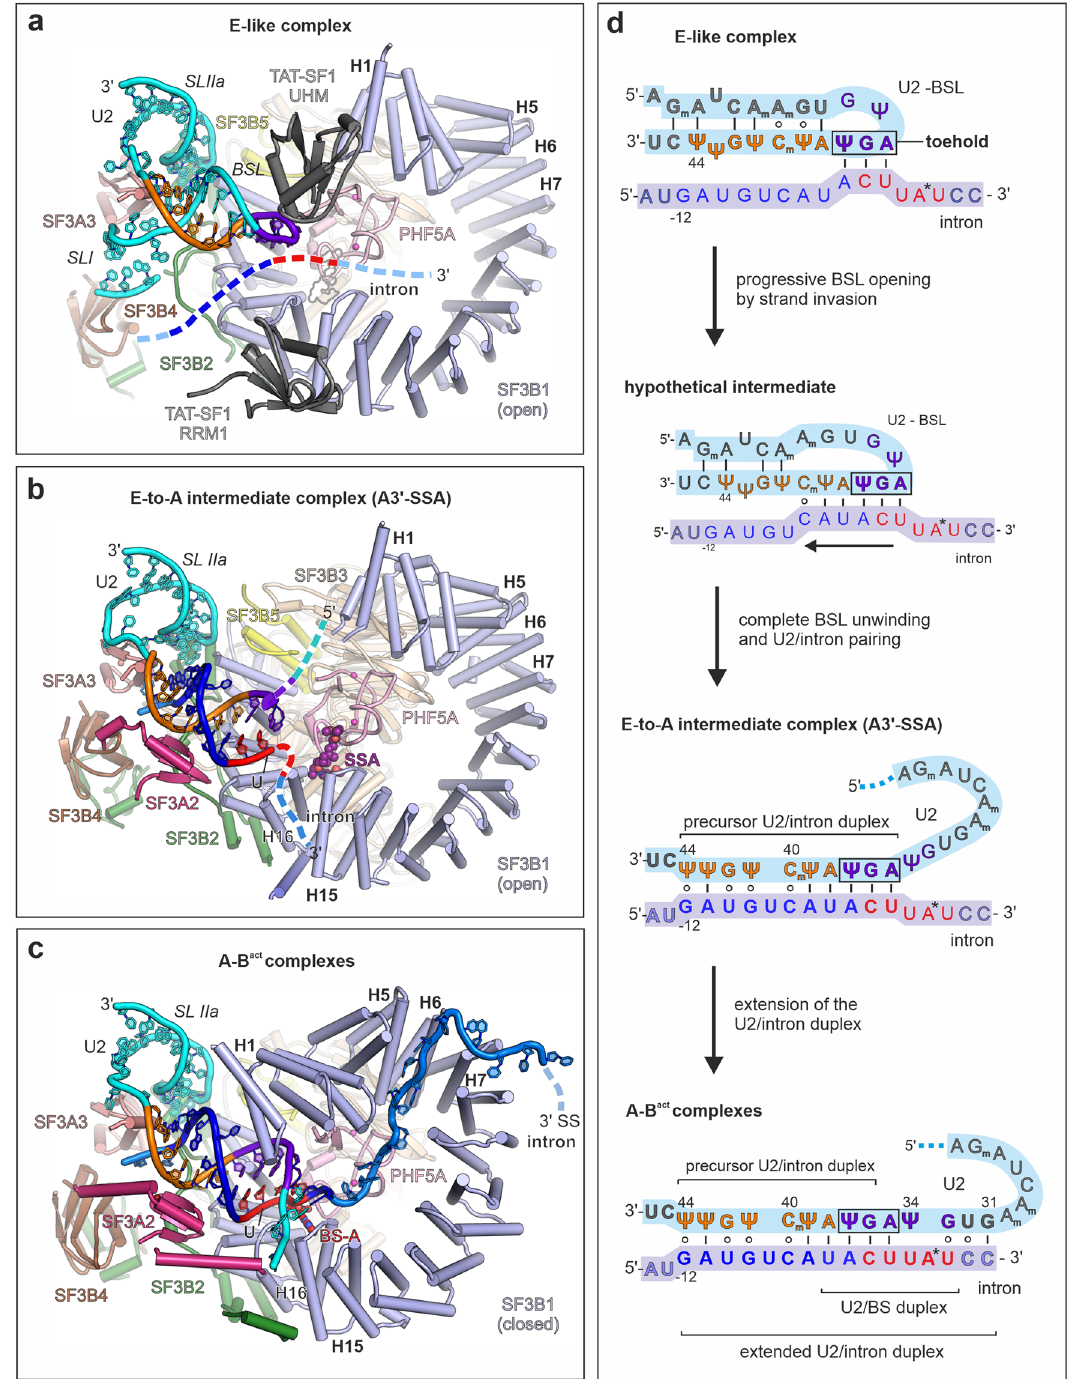
Fig. 6 Mechanism of the stepwise intron selection by U2 snRNP. a The E-like complex model is based on the 17S U2 snRNP structure (PDB 6Y50), which is positioned in the proximity of an intron schematic. The equivalent location of SSA is shown as a silhouette, for orientation ’ s sake. b Structure of the U2 5 ′ module of the A3 ′ complex arrested with spliceostatin A (SSA). c Structure of the U2 5 ′ module from the A/B act complexes. The depicted U2 5 ′ model is derived from the human B act coordinates (PDB 5Z58). Complexes from a to c were superimposed over equivalent residues from PHF5A and SF3B1. d Schematic RNA transitions during intron ’ s recognition by U2, as suggested by cryo-EM structures. Nucleotides resolved in cryo-EM structures are shown in bold letters and colored as in a . Ψ and the “ m ” subscript denotes pseudouridine and methylated nucleobases, respectively. Throughout the entire fi gure, the BS consensus and nucleotides from BSL ’ s loop are shown in red and purple, respectively. The remaining sequence of the intron and of the U2 snRNA are colored in deep blue and orange, respectively. RNA strands not resolved in cryo-EM structures are dashed. All the other subunits and elements are color- coded as in Fig.